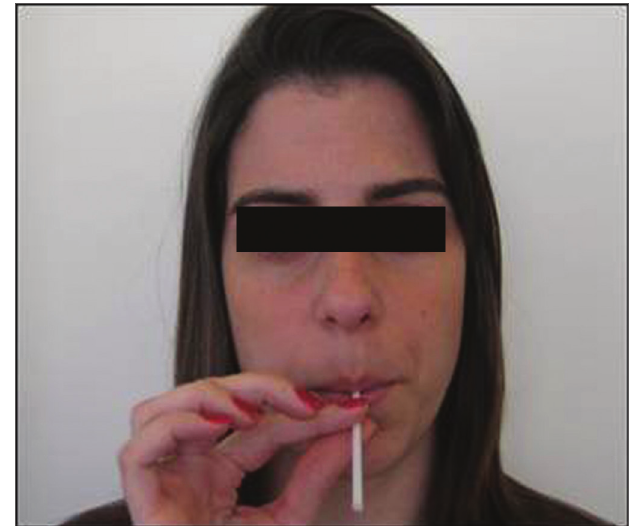
Figure 1. Semi-occluded vocal tract exercises, phonation into a